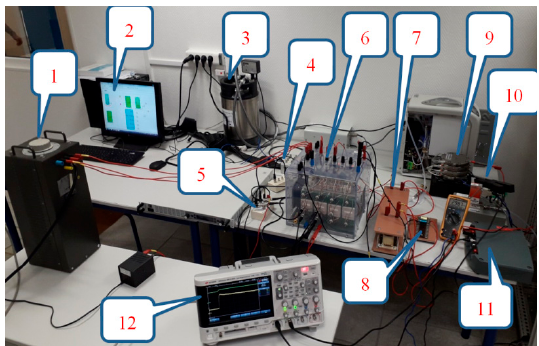
Figure 13. Experimental test rig in the laboratory. Table 6. Components of the SIBC converter [30].